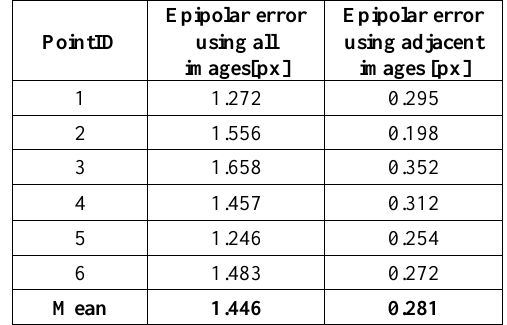
Table 6. Epipolar error for each point of test campaign